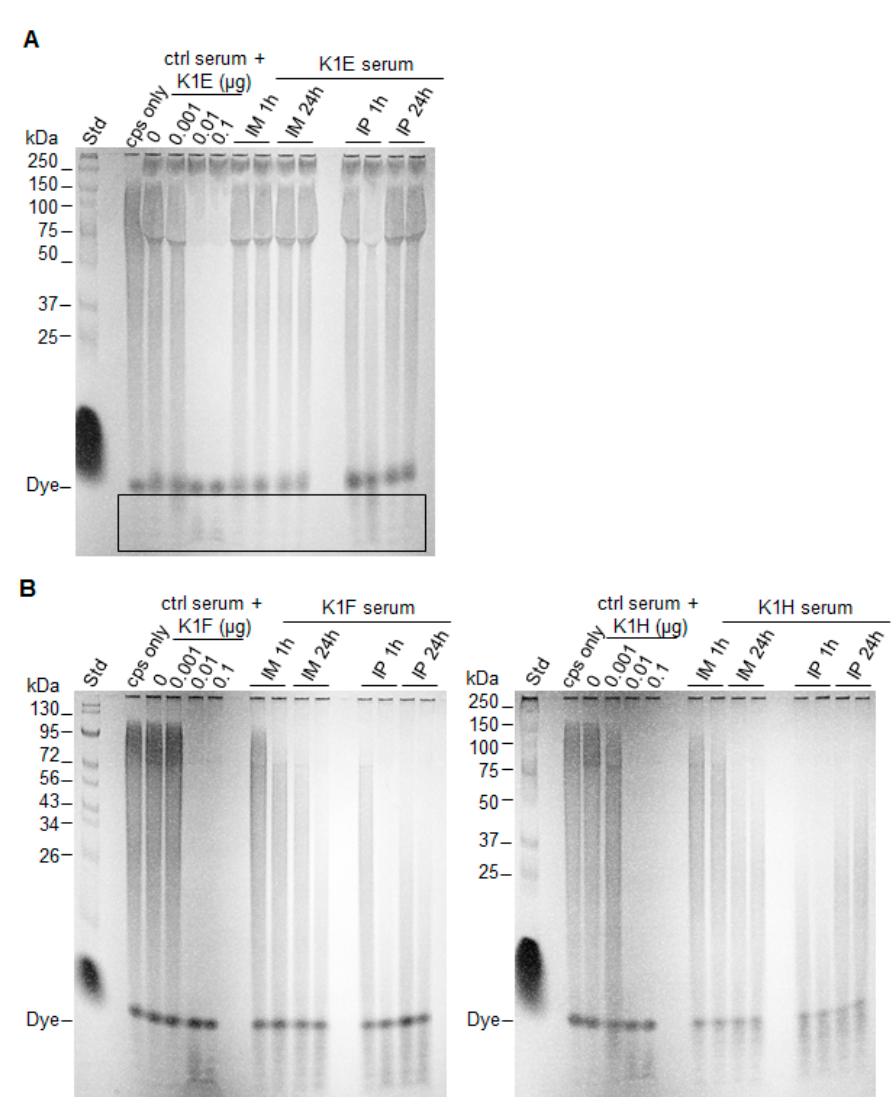
Figure 5. Comparison of depolymerase serum activity using different administration routes. Except for the molecular weight standard (“std”) on the left of each panel, each lane fractionates 10–20 ug of K1 capsule (“cps only”) or an overnight reaction of capsule incubated with serum and/or enzyme. Lanes with “serum” used serum from mice inoculated with enzyme ( A ) K1E; ( B ) K1F (left) or K1H (right) (IM or IP, 1 mg/kg weight) and sacrificed at 1 or 24 h. Two mice were tested for each route and time point, shown in separate lanes. Lanes with “ctrl serum” had different amounts of free enzyme added to the control serum (from mice not receiving enzyme injection), as the control reactions. Only a slight activity of K1E is evident, and then only for IP 1h (bottom of lane, boxed). In contrast, K1F and K1H both exhibit clear activity by both routes of administration, with a possible effect of route for K1H at 1 h.